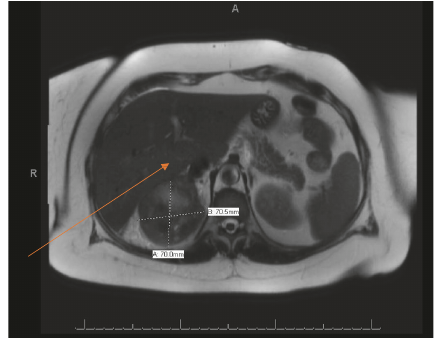
Figure 4: Resolution of liver metastases following neoadjuvant therapy.